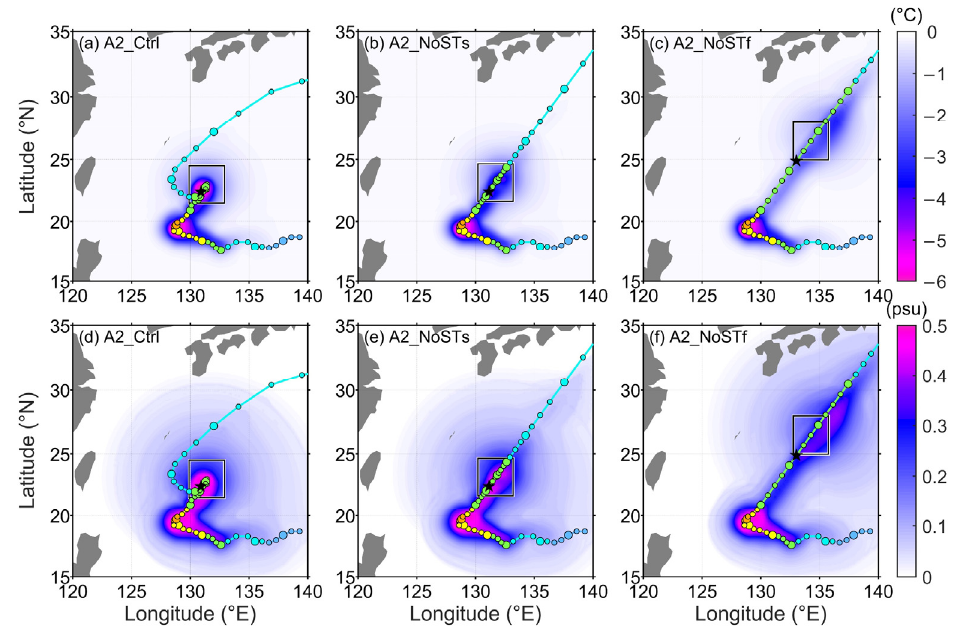
Figure 11. Spatial distribution of the maximum SST cooling and maximum SSS salinification caused by the passage of Typhoon Prapiroon in the 3DPWP experiments. ( a ) The maximum SST cooling in control Experiment A2_Ctrl; ( b ) the maximum SST cooling in Experiment A2_NoSTs; ( c ) the maximum SST cooling in Experiment A2_NoSTf; ( d ) the maximum SSS salinification in control Experiment A2_Ctrl; ( e ) the maximum SSS salinification in Experiment A2_NoSTs; and ( f ) the maximum SSS salinification in Experiment A2_NoSTf. The solid box is the second focused domain of sudden turning of the typhoon, denoted A2. The coloured lines and dots represent the track and intensity of the typhoon. The black stars represent the positions of the T/S profiles in Figure 13.